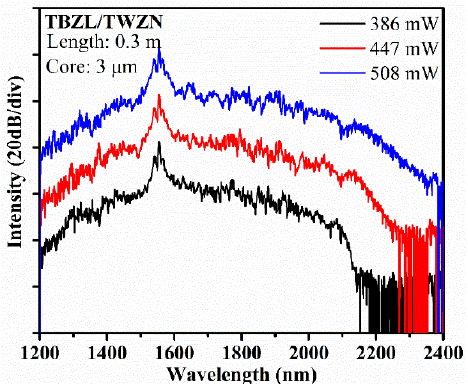
Figure 5. Dependence of the measured SC spectrum from 30 cm TBZL/TWZN fiber on the pumping power of a 1560 nm fs fiber laser.